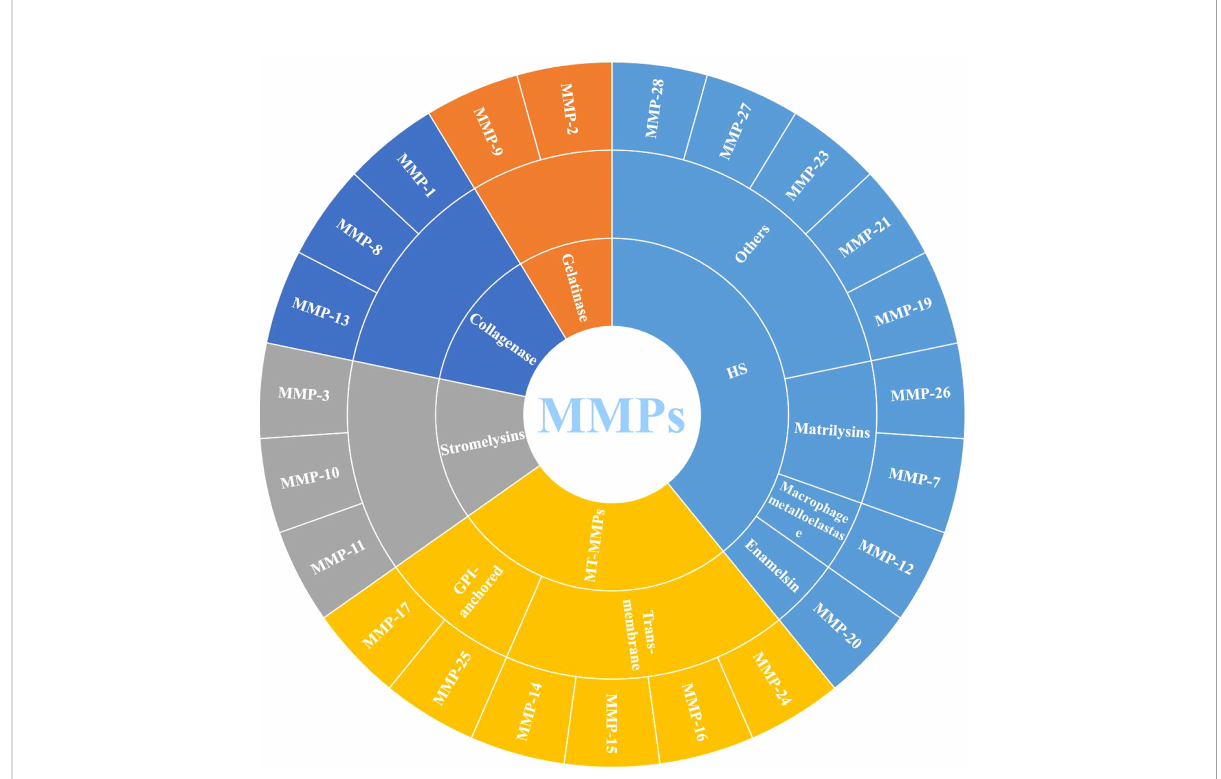
FIGURE 1 Classi fi cation of MMPs (MMPs: Matrix metalloproteinases; MT-MMPs: Membrane-type MMPs, and HS: Heterogeneous